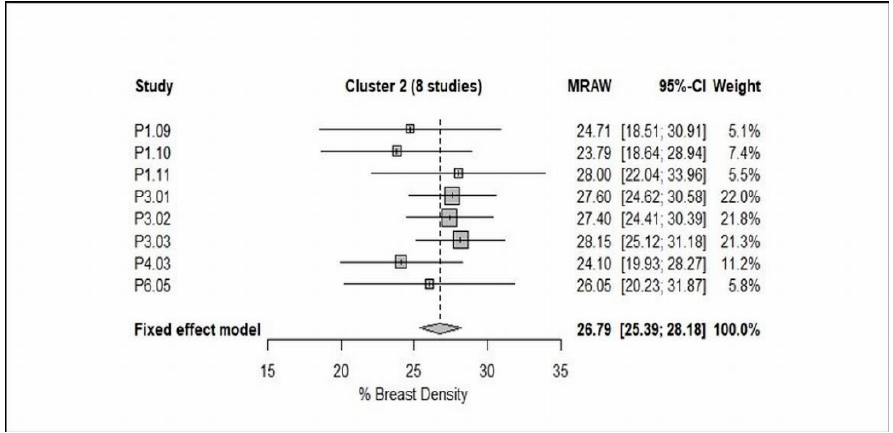
Figure 7. Forest plot of the study means, and 95% confidence limits of the studies in Cluster 2 (8 studies) of % breast density.